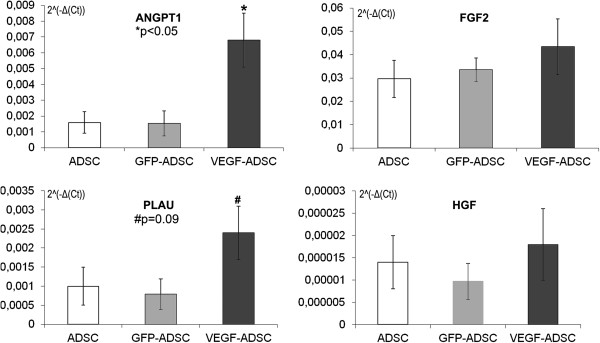
Comparison of ANGPT1, FGF2, PLAU and HGF genes expression by quantitative PCR in GFP-ADSC, VEGF-ADSC and unmodified ADSC. Charts represent relative expression for assayed genes from a total of 6 runs.